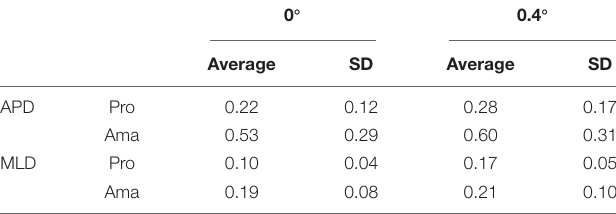
TABLE 5 | Average absolute errors in final ball position.